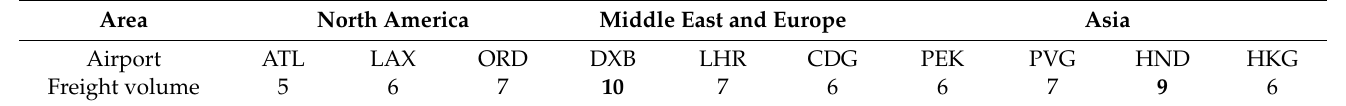
Table 6. The optimal number of fuzzy sets for the time series of fuzzy air